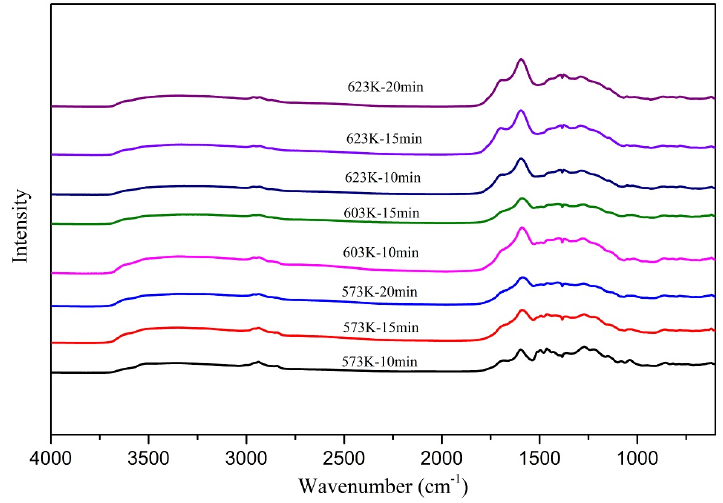
Figure 2. FTIR spectra of the